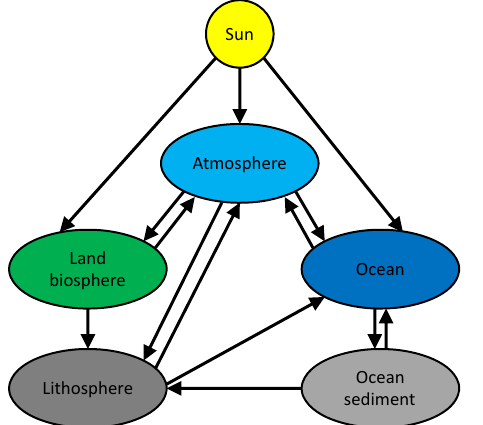
Figure 1. Modules and interconnections for the Danish Center for Earth System Science (DCESS) Earth system model.